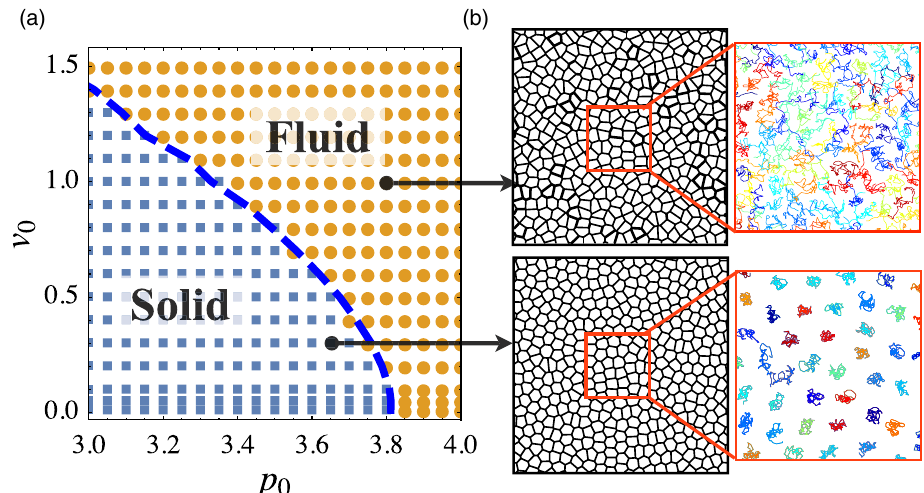
1 . Blue r ¼ ). The dynamical ffiffiffiffi eff p A i ¼ 3 . 81